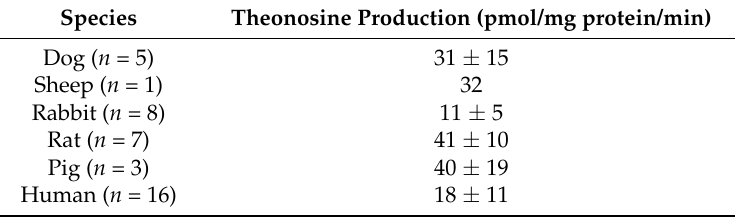
Table 1. Production of theophylline-7 β - D -ribofuranoside (theonosine) by lung microsomal tissue from various mammalian species incubated with 1 mM theophylline. Data are presented as mean ± SD when n >